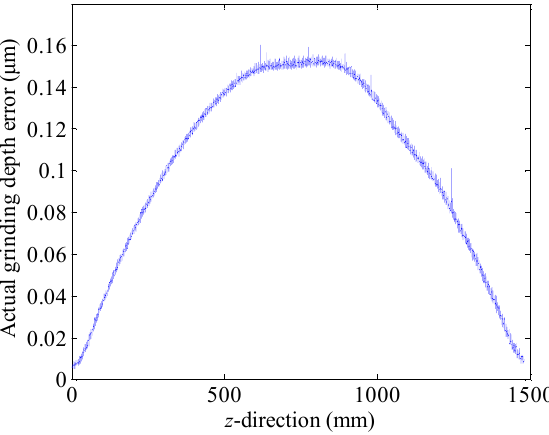
Figure 13. Actual grinding depth error after compensation.